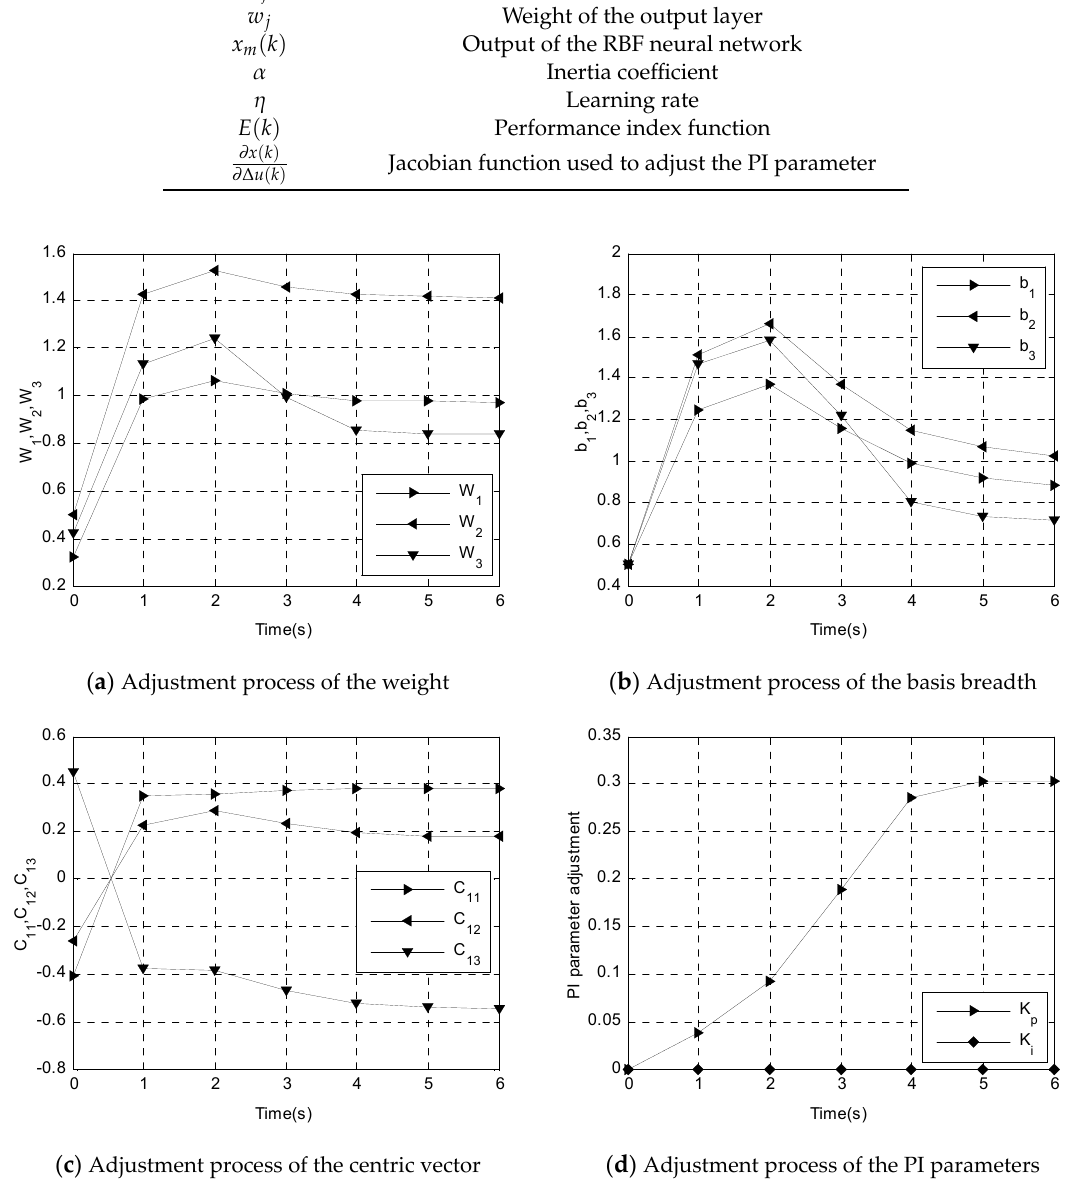
Figure 17. The adjustment process of the RBF neural network controller. Table 2. Definitions of the given symbols of the RBF neural network.